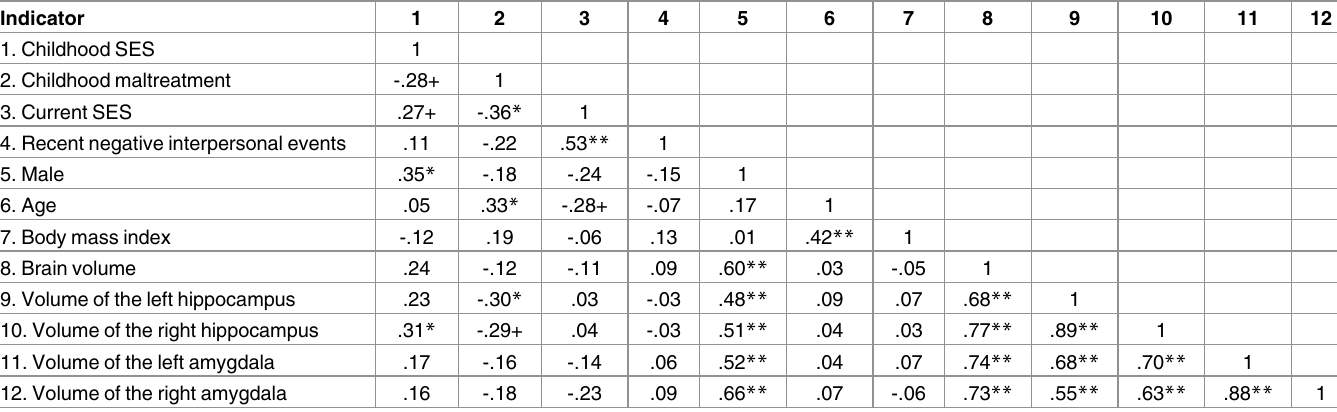
Table 2. Correlation matrix. Indicator